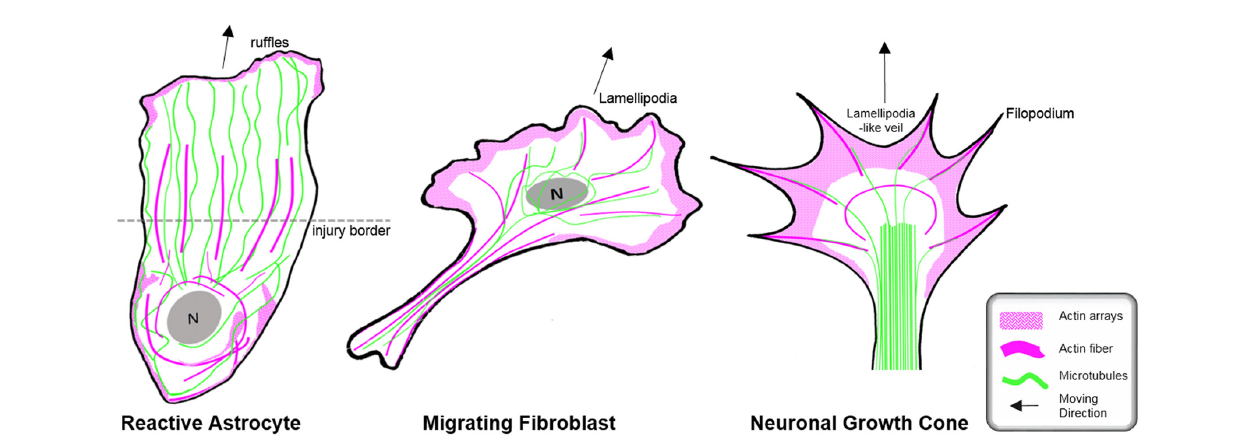
FIGURE 6 | Organization of the cytoskeleton in reactive astrocytes in comparison to fibroblasts and neurons in vitro . Schematic drawings of microtubules (green) and F-actin arrays and fibers (magenta) in cultured mouse astrocytes after injury (left), migrating fibroblasts (center) and in extending axonal growth cones of developing neurons (right). The dashed line indicates the injury border and the nucleus is shown in gray (N). Elongated polygonal astrocytes at the wound edge extend into the cell-free space and have actin filaments (magenta) that are organized around the cell body and in bundles reaching into the center of the processes, while the leading edge possesses only a narrow outer rim of filamentous actin within sparse ruffles (left). Microtubules are enriched throughout the processes and reach into the extreme tip. In contrast, both fibroblasts and neuronal growth cones exhibit prominent actin arrays and fibers in the periphery of their leading edge forming filopodia, lamellipodia or lamellipodia-like veils. Most of their microtubules are present behind the actin-rich periphery, where microtubules form dense parallel bundles in growth cones. Microtubules extending into the actin-rich periphery frequently associate with actin fibers of